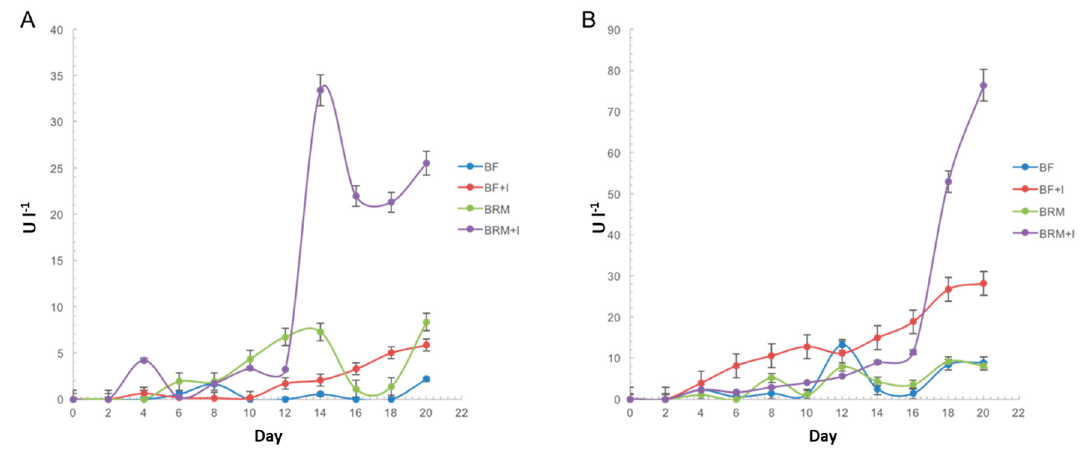
Figure 1. Time course of laccase production in BF or rich medium for Basidiomycota (BRM) media, alternatively supplemented with 0.1 mM MnSO 4 , 0.1 mM FeSO 4 , 0.35 mM CuSO 4 and 3% ethanol (BF + I, BRF + I) by ( A ) T. maxima LE130 and ( B ) Trametes sp. LA1. The values are the mean of three replications ±